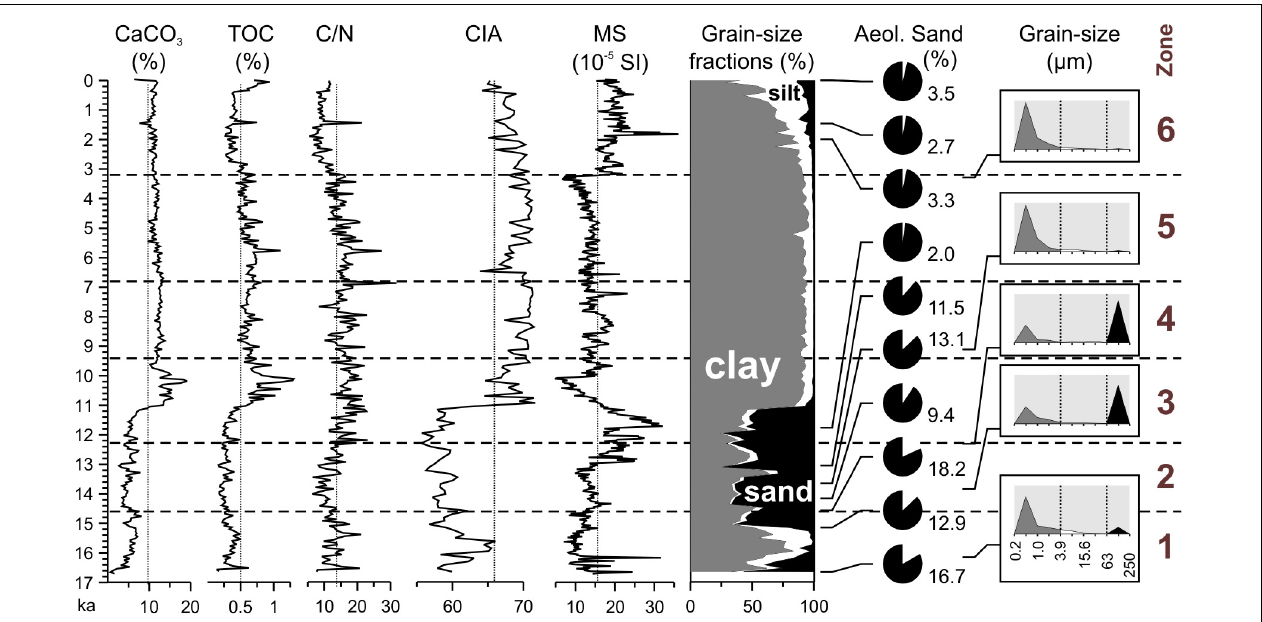
FIGURE 2 | Magnetic susceptibility (MS) of the ULB core in comparison to carbonate content, TOC concentration, C/N ratio, the CIA and grain-size data (Lee et al., 2011, 2013). Differences in the contribution of aeolian sand to the sand fraction of ten selected samples are estimated semi-quantitatively assuming that the grain-size fraction 180–250 µ m mostly represents air-borne particles. Typical dune sand in the region has a mode at ca. 200 µ m. The height of the gray boxes of the grain-size distributions at the right represents 70%. Zonation based on the fossil record ( Figure 3 ).